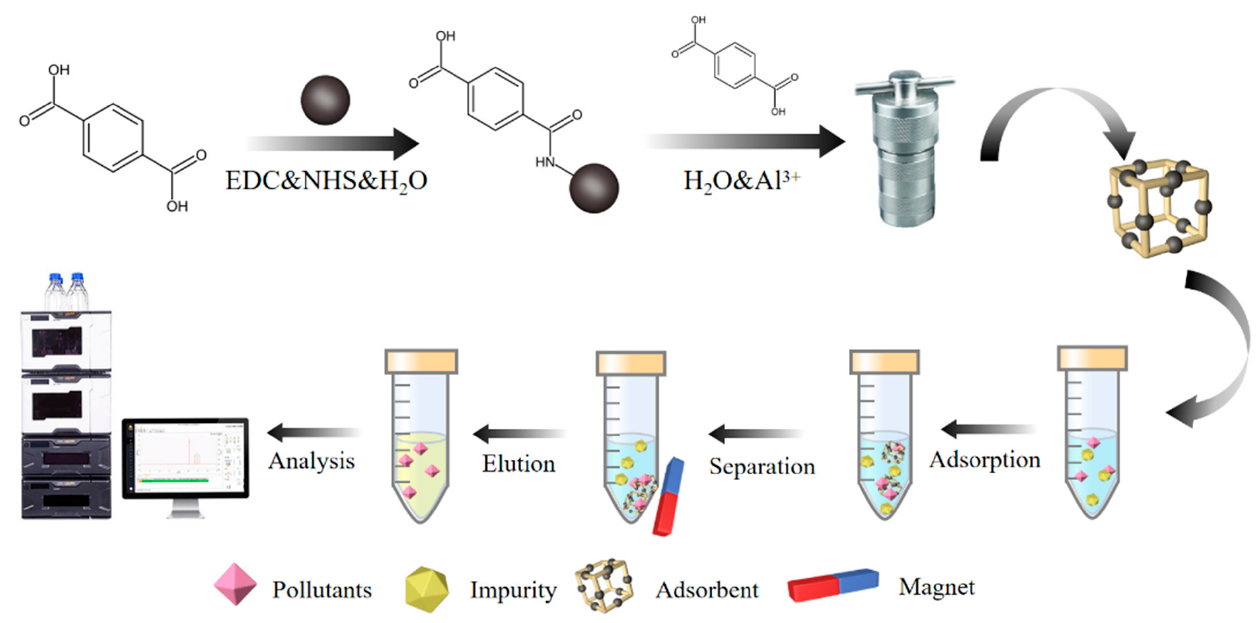
Figure 1. Schematic diagram for the synthesis of Fe 3 O 4 @MIL-53(Al) and MSPE process.